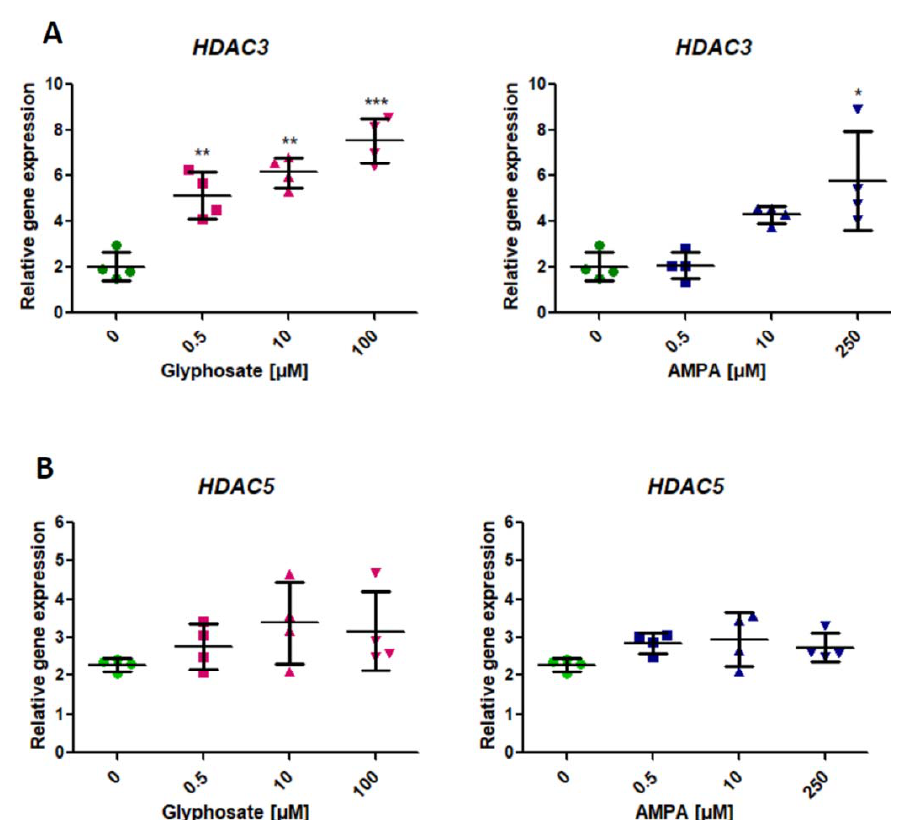
Figure 3. Expression of genes involved in the histone deacetylation— HDAC3 ( A ) and HDAC5 ( B ) in human PBMCs incubated with glyphosate (0.5–100 μ M) and AMPA (0.5–250 μ M) for 24 h. Mean ± SD was calculated for four individual